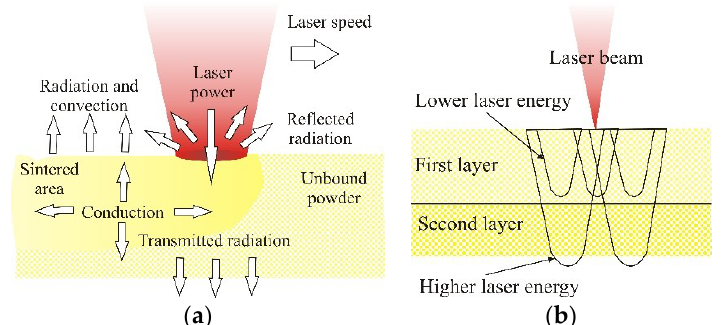
Figure 1. ( a ) Laser power influence on the sintering process, ( b ) selection of laser power/energy input [19,20].